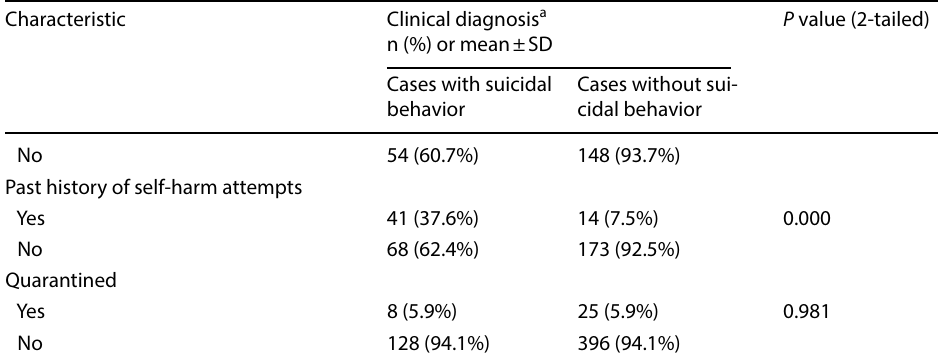
are excluded from the denominator)